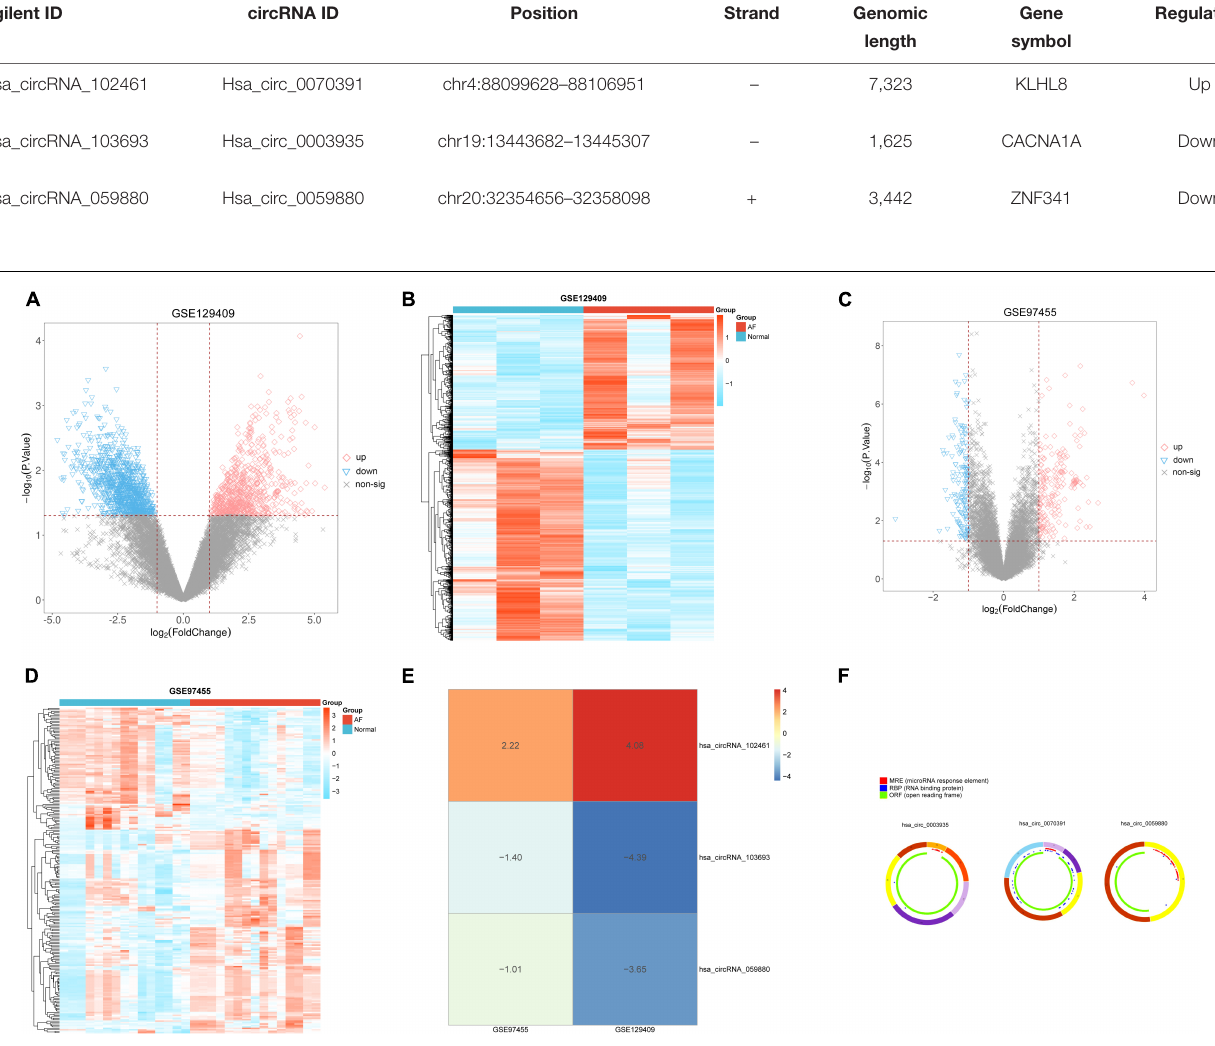
FIGURE 1 | Identification of differentially expressed circRNAs (DECs) in two circRNA microarray datasets. (A) Volcano plot of 663 upregulated DECs and 940 downregulated DECs in the GSE129409 dataset; (B) the heatmap of DECs obtained from the GSE129409 dataset; (C) volcano plot of 142 upregulated DECs and 85 downregulated DECs in the GSE97455 dataset; (D) the heatmap of DECs obtained from the GSE97455 dataset; (E) the DECs of the two datasets were integrated and ranked with a robust method, the screened criteria were the p < 0.05, Three DECs were screened by integrating two datasets; and (F) the basic characteristics and structure patterns of these three